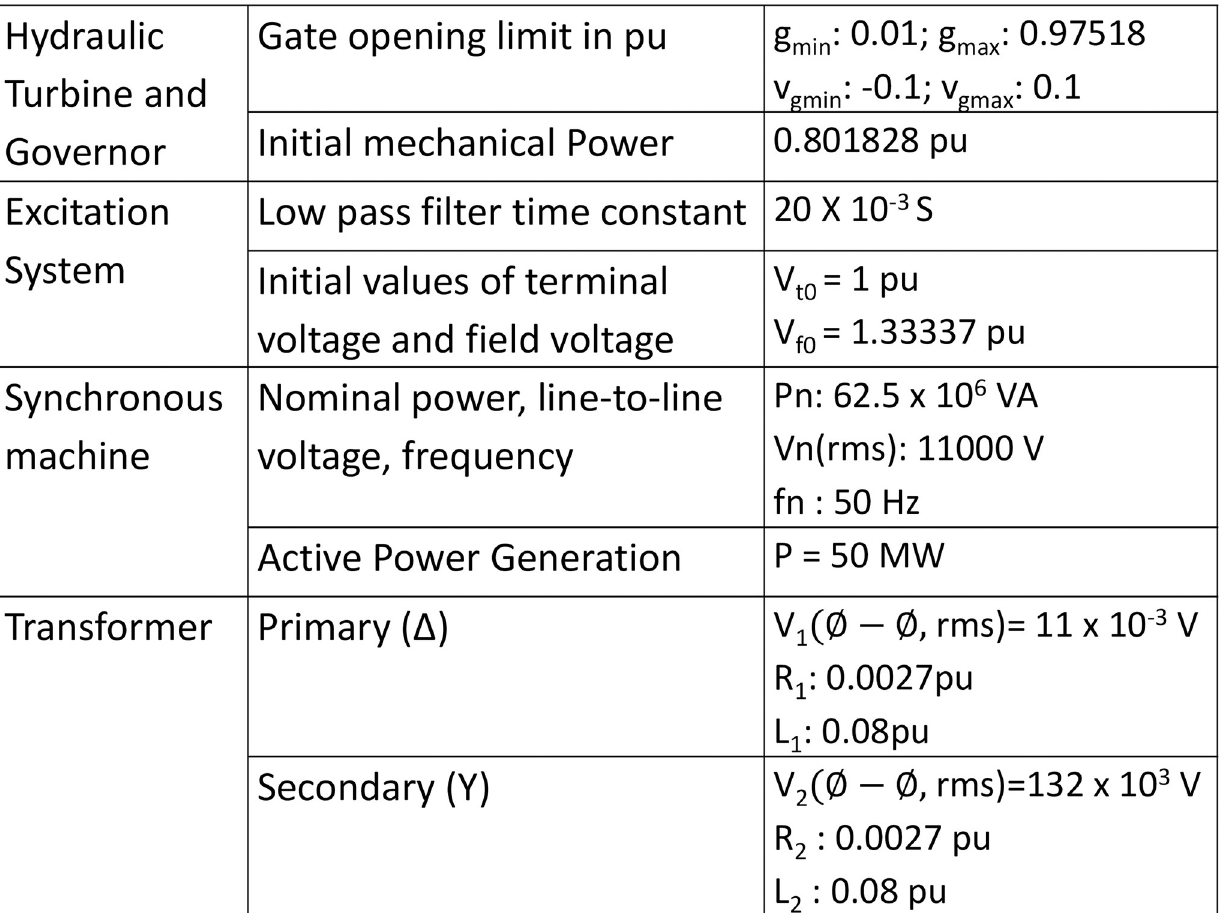
Fig 4. Nomenclature of design specifications for simulating the existing model of unit-4 of the KH plant.